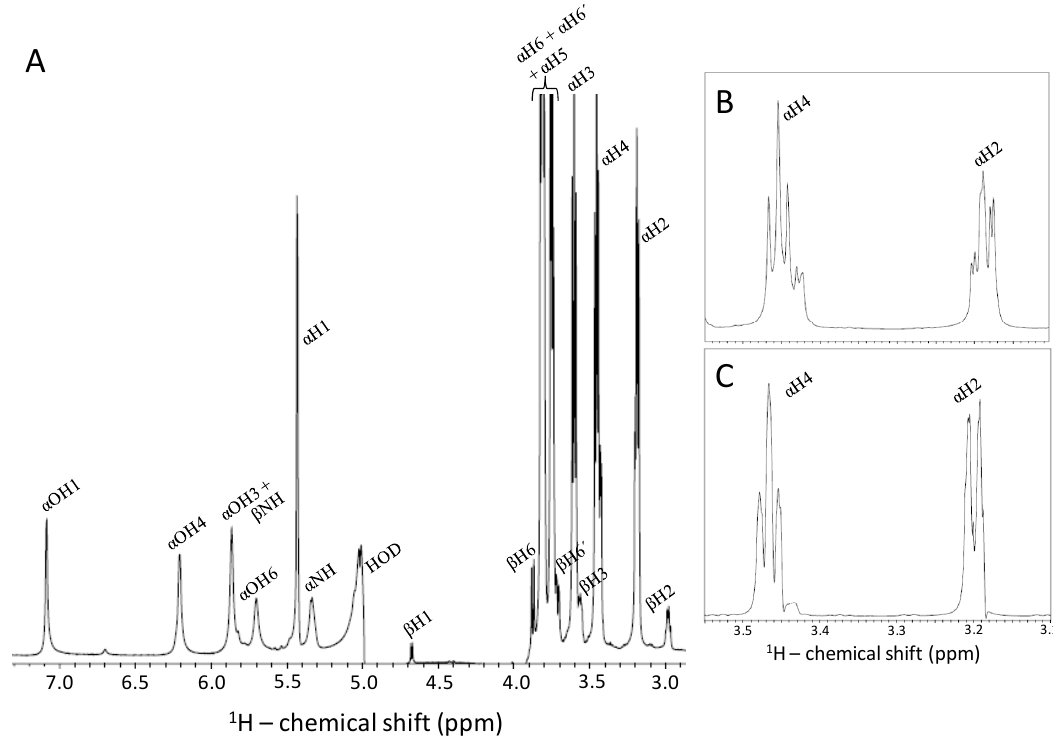
Figure 5. 1D 1 H NMR spectra of N -sulfo-glucosamine (GlcNS). Expansions are 2.9–7.3 ppm ( A ) and 3.10–3.55 ppm ( B and C ) for GlcNS (10 mg/mL) dissolved in 10%:20%:70% D 2 O/acetone/H 2 O for spectra recorded in 18.8 T NMR instrument at 3 °C ( A and B ) or 37 °C ( C ). Spectrum in panel B is just a close-up window of the correspondent region in spectrum of panel A.